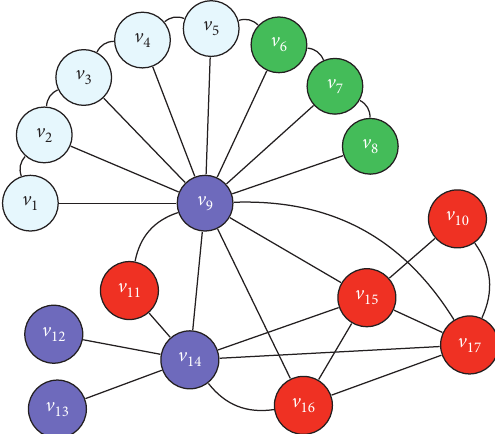
Figure 2: The problem existed in the initial community